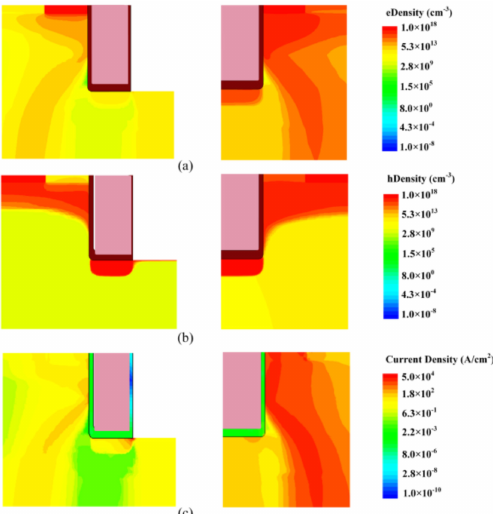
Figure 10. ( a ) Electron, ( b ) hole density distribution, and ( c ) current distribution inside (left) FS- and (right) C-TMOS at the time point T2.